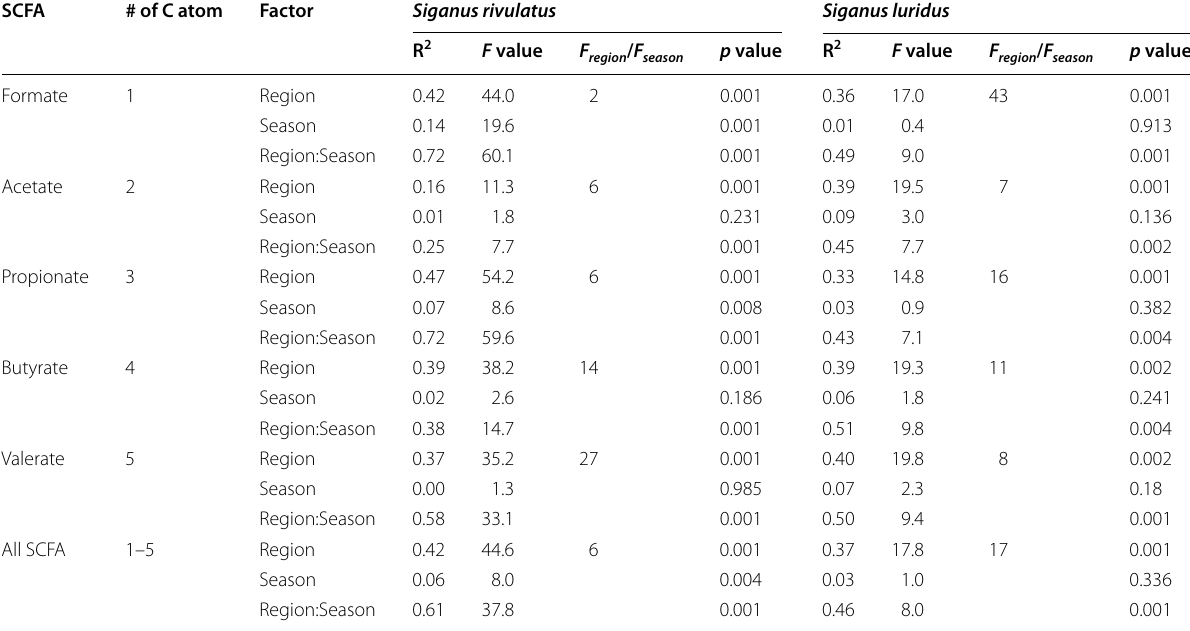
The reported values correspond to averages of tests performed using dissimilarity estimated with relative abundances of KEGG Orthologies associated with the metabolism of short-chain fatty acids (SCFA) with different number of C